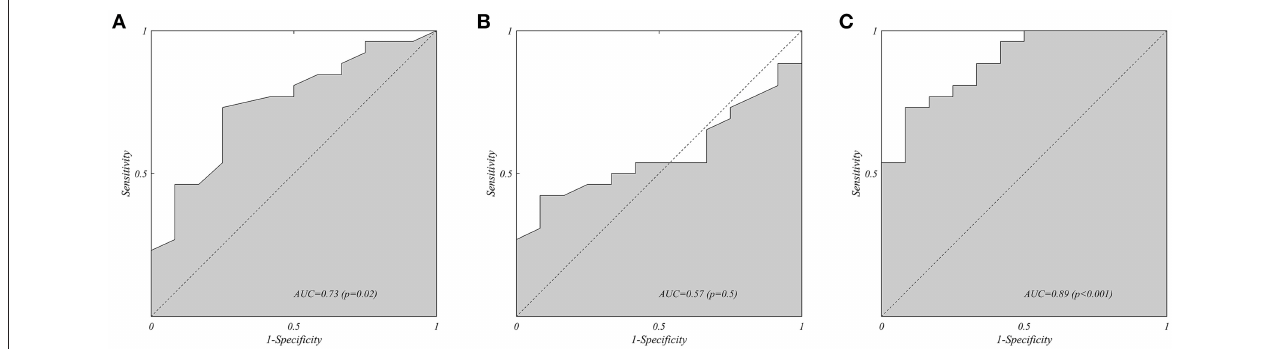
FIGURE 3 | Receiver Operating Characteristic Analysis (ROC) on the all grade Responder Status (R/RS, vs. NR/NegR) at midterm follow, for the hemodynamic force ratio: (A) RMSx/RMSz measured PRE implant, (B) RMSx/RMSz measured POST implant, and (C) early variation δ (RMSx/RMSz) from PRE implant to POST implant. The presence of poor alignment of forces before implant has a mild predictive value for the responder status (A) ; this does not apply for the value measured after implant (B) . Moreover, the improvement of alignment induced by biventricular pacing shows the best predictive value of the eventual responder status at follow up.